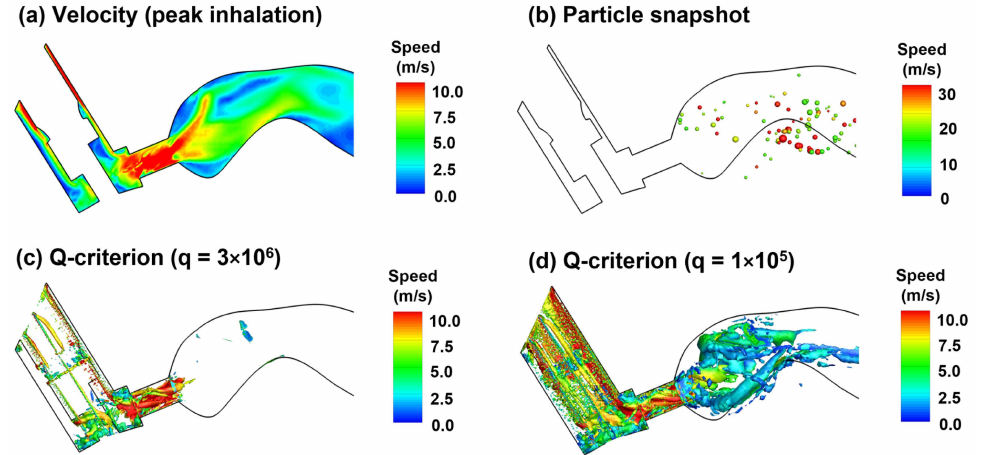
Figure 7. Airflow and droplet dynamics at peak inhalation (1.23 s, 61.2 L/min): ( a ) mid-plane 2D velocity contour, ( b ) snapshots of droplet positions, and instantaneous vortex structures defined by Q-criterion at two different levels ( c , d